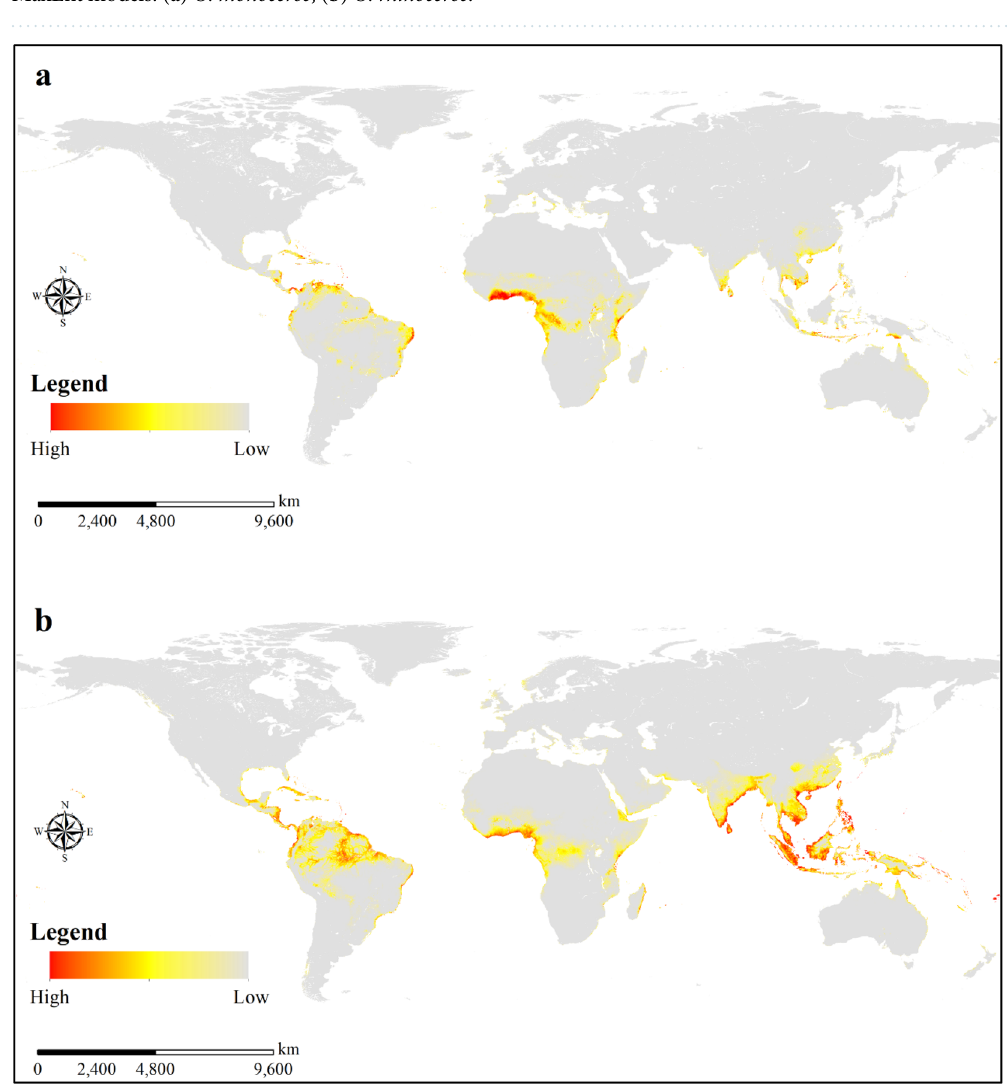
Figure 4. Global potential distribution maps generated by MaxEnt for: ( a ) O. monoceros ; ( b ) O. rhinoceros. MaxEnt 3.4.1 (https:// biodi versi tyinf ormat ics. amnh. org/ open_ source/ maxent/) and ESRI ArcMap 10.2.2 (https:// suppo rt. esri. com/ en/ Produ cts/ Deskt op/ arcgis- deskt op/ arcmap/ 10-2- 2# downl